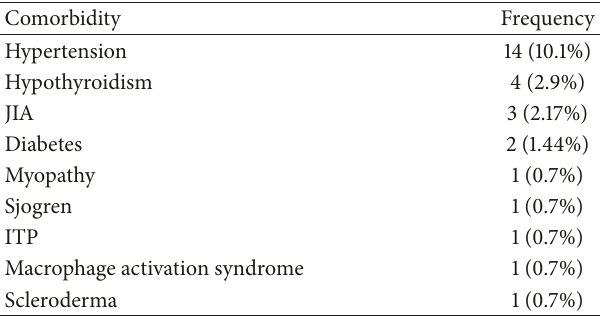
Table 1: Comorbidity in children with systemic lupus erythemato-